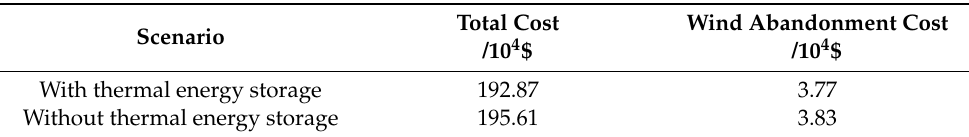
Table 4. Impact of thermal energy storage on low-carbon economics